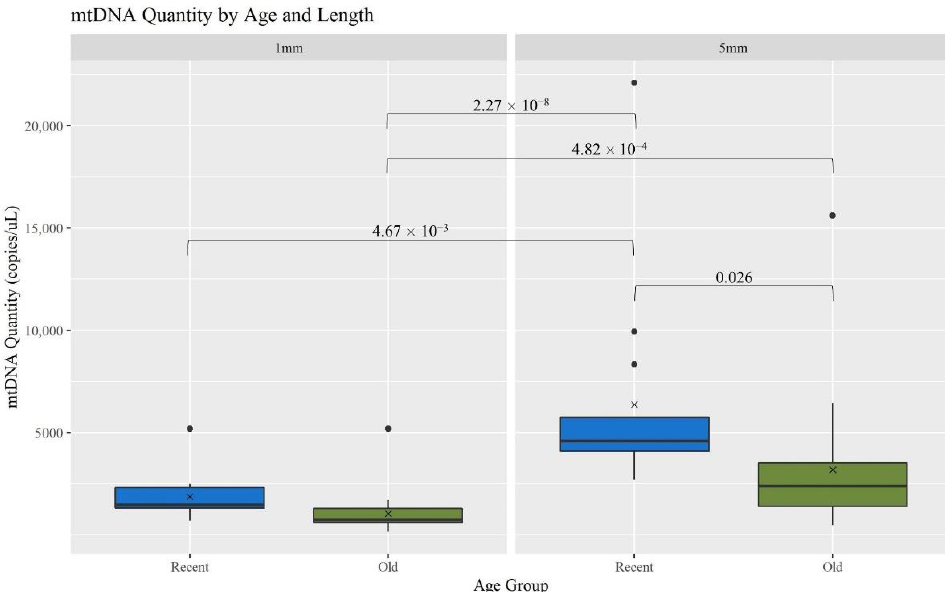
Figure 2. Boxplots for the comparison of mtDNA quantity for each age group and length (n = 74; n R = 26, n O = 48). The ‘x’ on the boxplots represents the mean and the line represents the median. Brackets show comparisons with significant p -values ( p < 0.05).